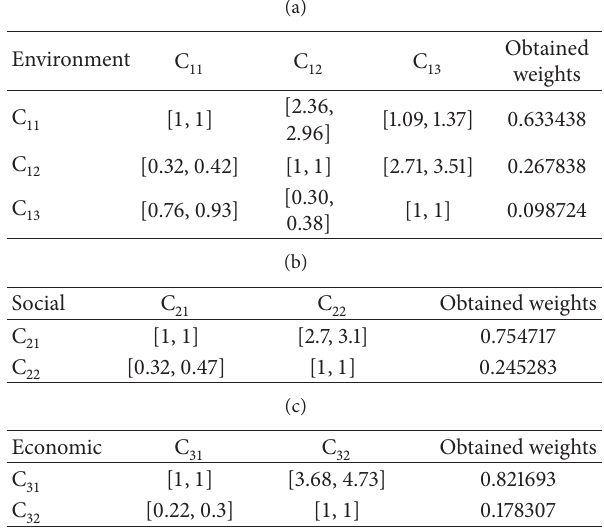
Table 12: The interval approximation subcriteria concerning the main criteria.